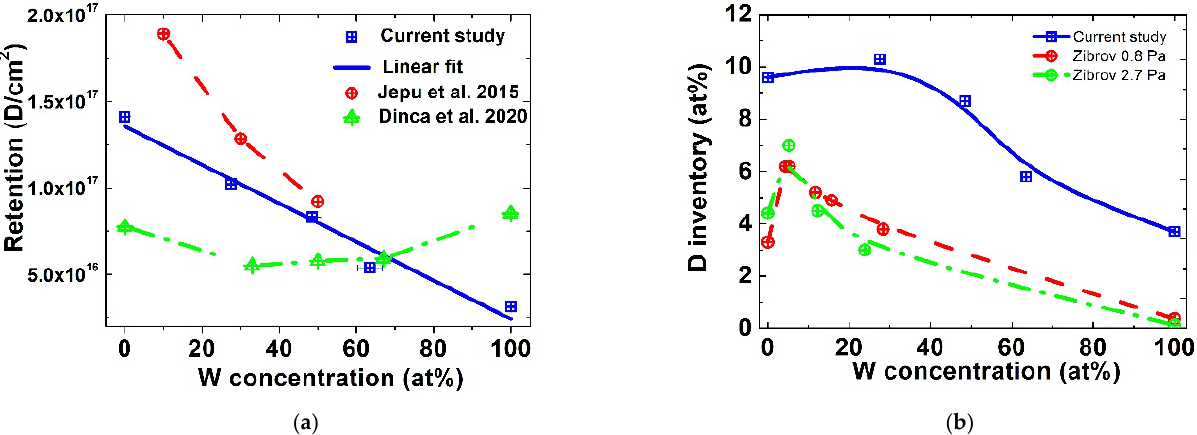
Figure 10. ( A ) Total deuterium retention as a function of W concentration. Data reported by Jepu et al. and Dinca et al. ( B ) Deuterium inventory as a function of W concentration plotted along with data from Zibrov et al. for mixed layers deposited 0.8 Pa and 2.7 Pa.